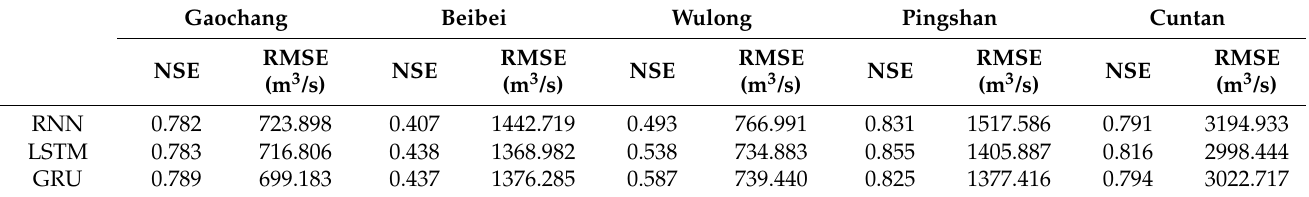
Table 8. The performance of RNN, LSTM, and GRU models at monthly runoff prediction with optimal time lag and lead time.